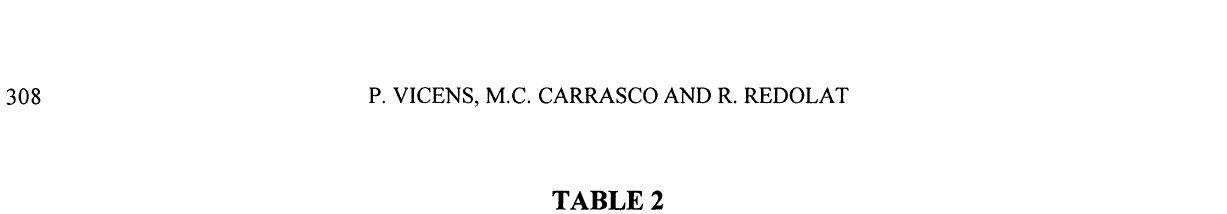
Mean Percentages Search Times in Quadrants during Probe Trial at two months of age (Training Phase) Group